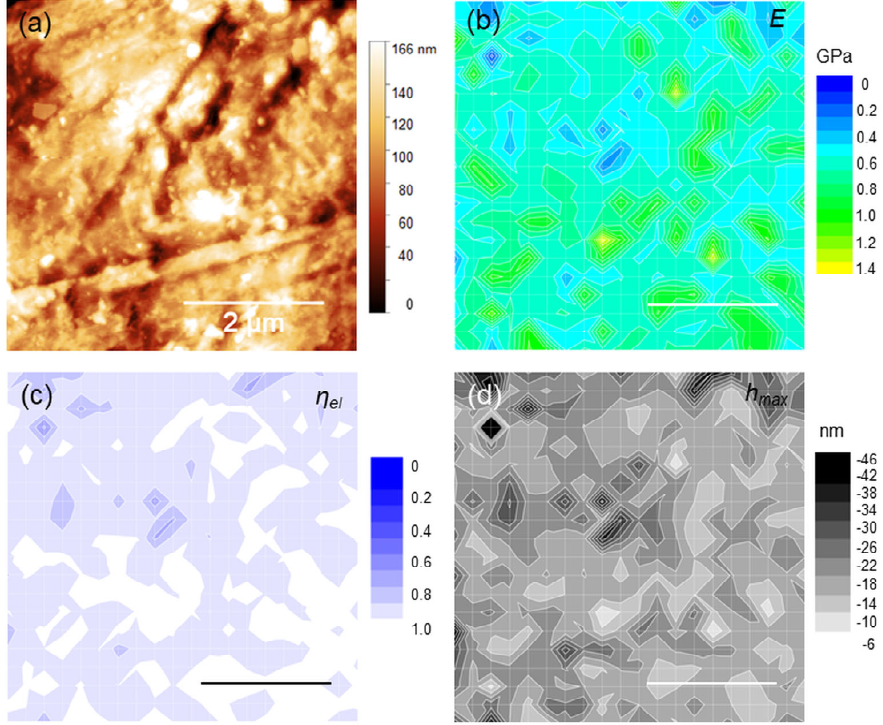
Figure 4. ( a ) 5 × 5 μ m 2 topography of a different sample region; ( b – d ) corresponding E, η el and h max maps.